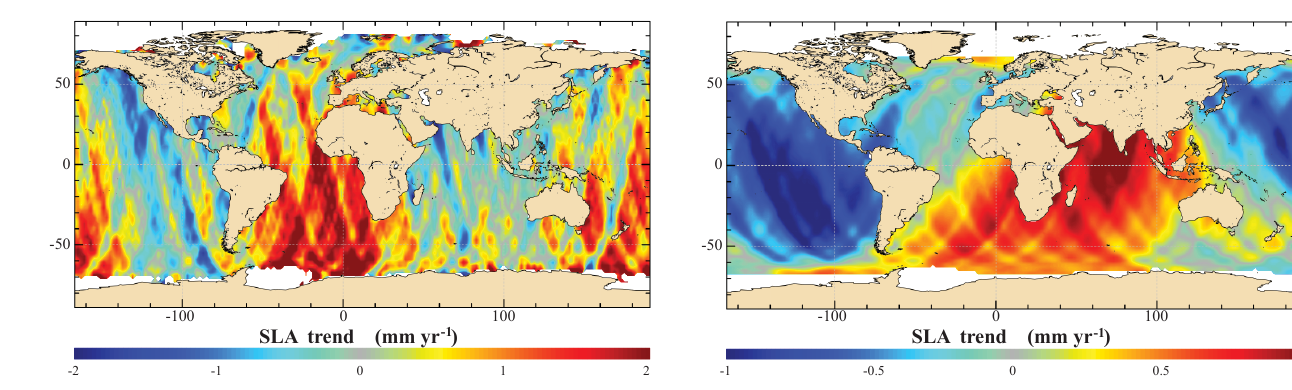
Figure 3. Change in SLA trend for Jason-1 sea level upon a switch from CNES orbit POE-D to